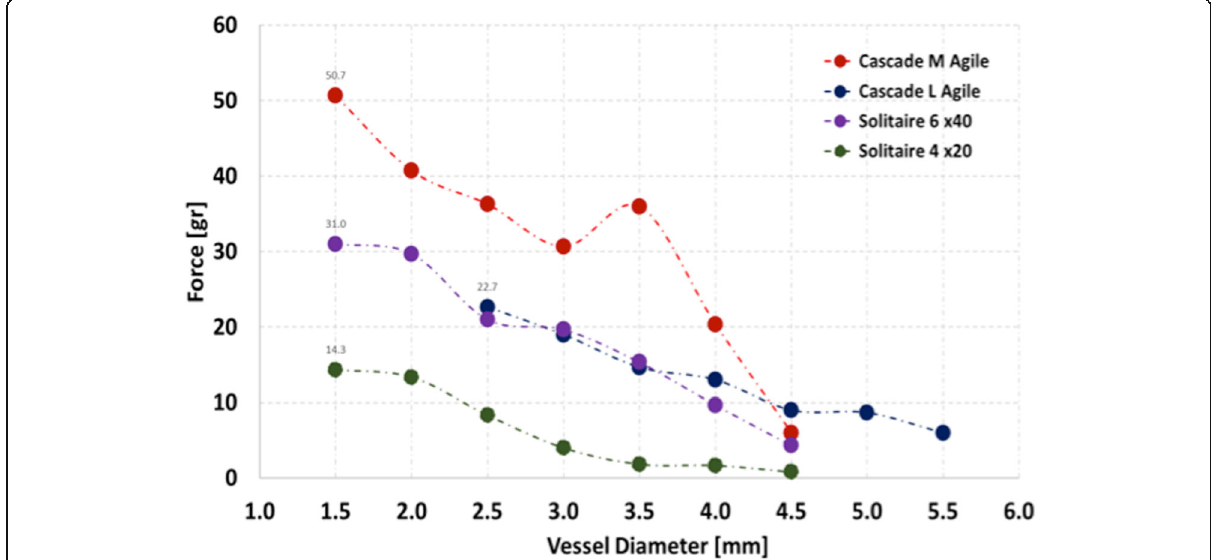
Fig. 8 The maximal expansile force generated by each device at different diameters. The Cascade M Agile consistently generated significantly higher forces than either of the Solitaires and the Cascade L Agile. The forces generated by the Cascade devices gradually decreases towards 0 as their unconstrained/maximum diameter is